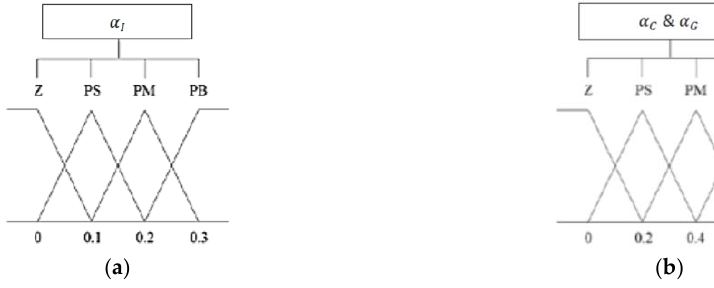
Figure 10. Membership functions of fuzzy logical control (FLC)-Input: ( a ) Language variable architecture of M ; ( b ) Language variable architecture of M .